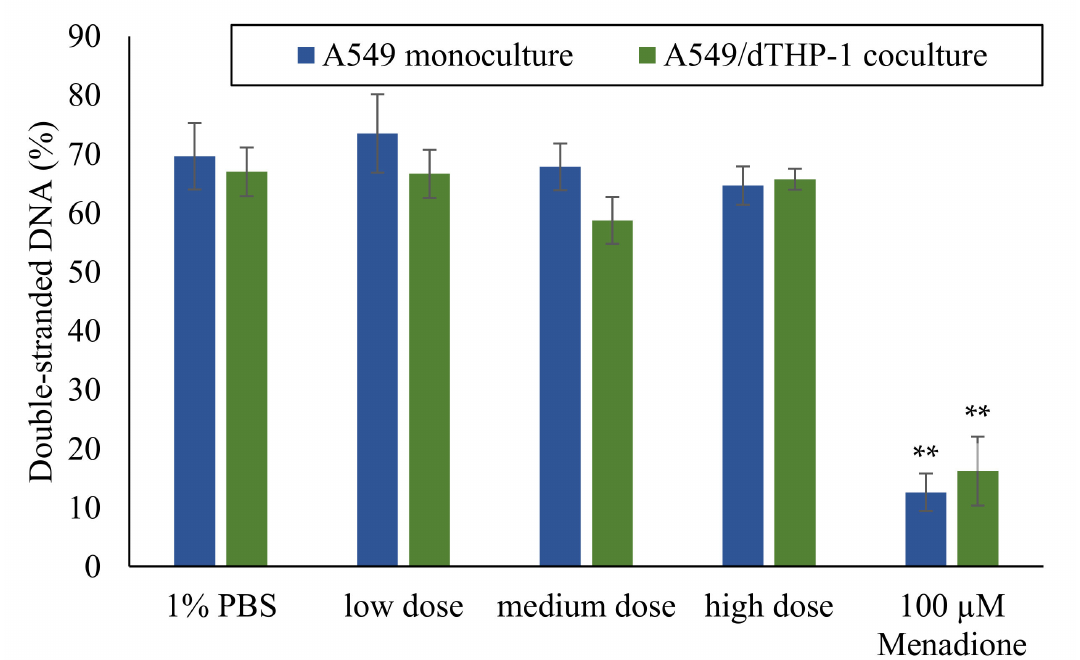
Figure 6. Assessment of DNA strand breaks after ALI-exposure of A549 mono-cultures and A549/dTHP-1 co-cultures to Min-U-Sil5. A549 and dTHP-1 cells were exposed to three differ- ent doses ( µ g/cm 2 ) of Min-U-Sil5 (A549: 15.8 ± 0.8 (low), 29.1 ± 2.4 (medium), 59.4 ± 2.0 (high); A549/dTHP-1: 15.9 ± 0.6 (low): 32.2 ± 2.9 (medium): 55.9 ± 2.9 (high) and incubated for 24 h. As a positive control, cells were treated with menadione to trigger oxidative DNA damage. The means of three independent experiments are displayed. Applied doses were calculated as means ± SD from three independent experiments. Statistical analysis was performed to assess differences between the quartz exposed cells and the PBS control applying the student’s t -test: ** ( p ≤